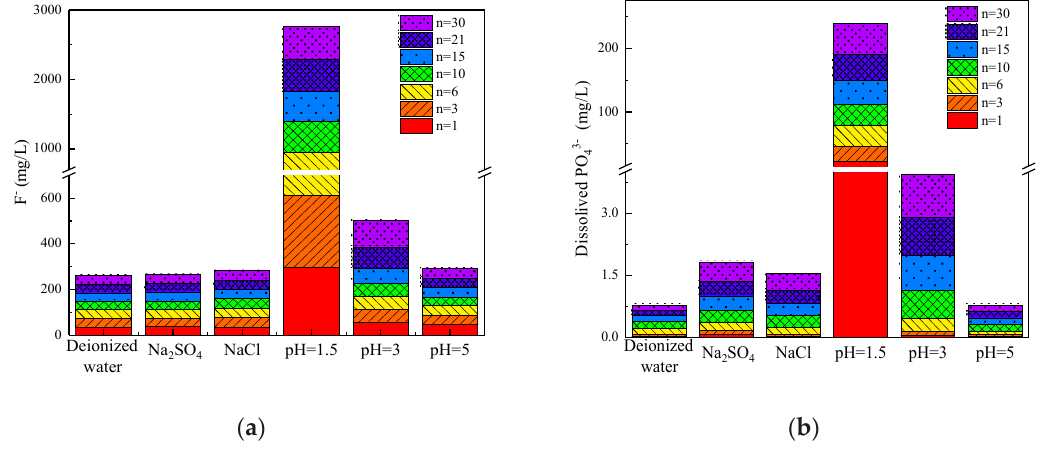
Figure 10. The cumulative leaching quantities of hazardous impurities in leachates: ( a ) The cumulative leaching quantities of fluoride and ( b ) the cumulative leaching quantities of dissolved phosphate.